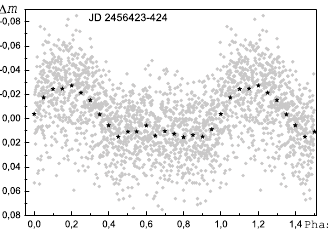
Figure 9: Ordinary superhumps on days 17-18 AM.